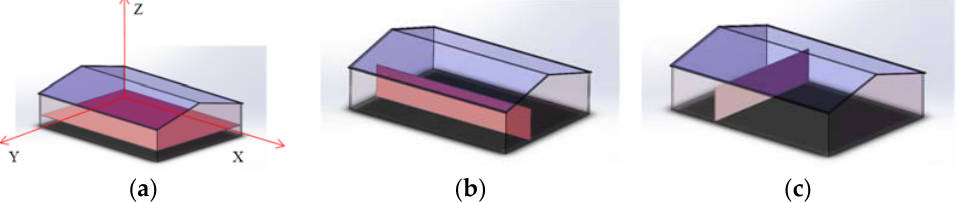
Figure 2. Layout of temperature measurement in the granary. ( a ) Plane parallel to XOY . ( b ) Plane parallel to XOZ . ( c ) Plane parallel to YOZ .